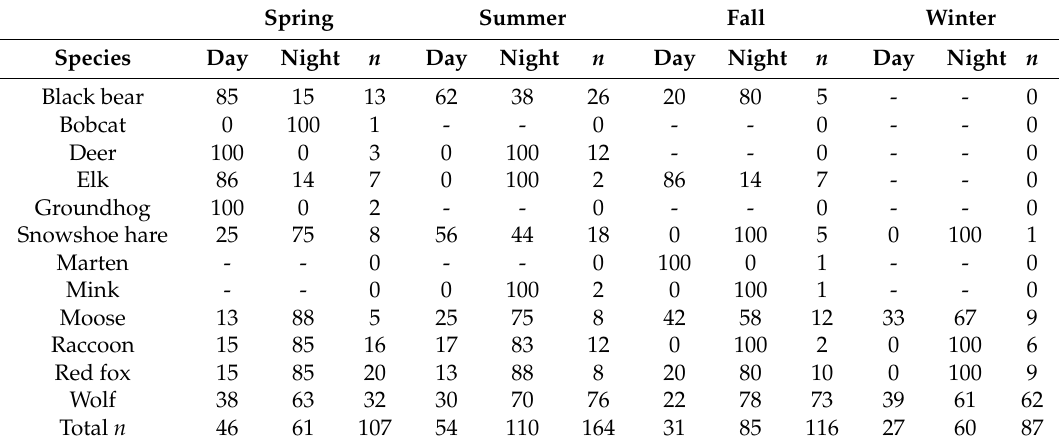
Table 3. The percentage and total number ( n ) of camera capture events of mammals on the railway during the day and night for each season (2015 to 2016).